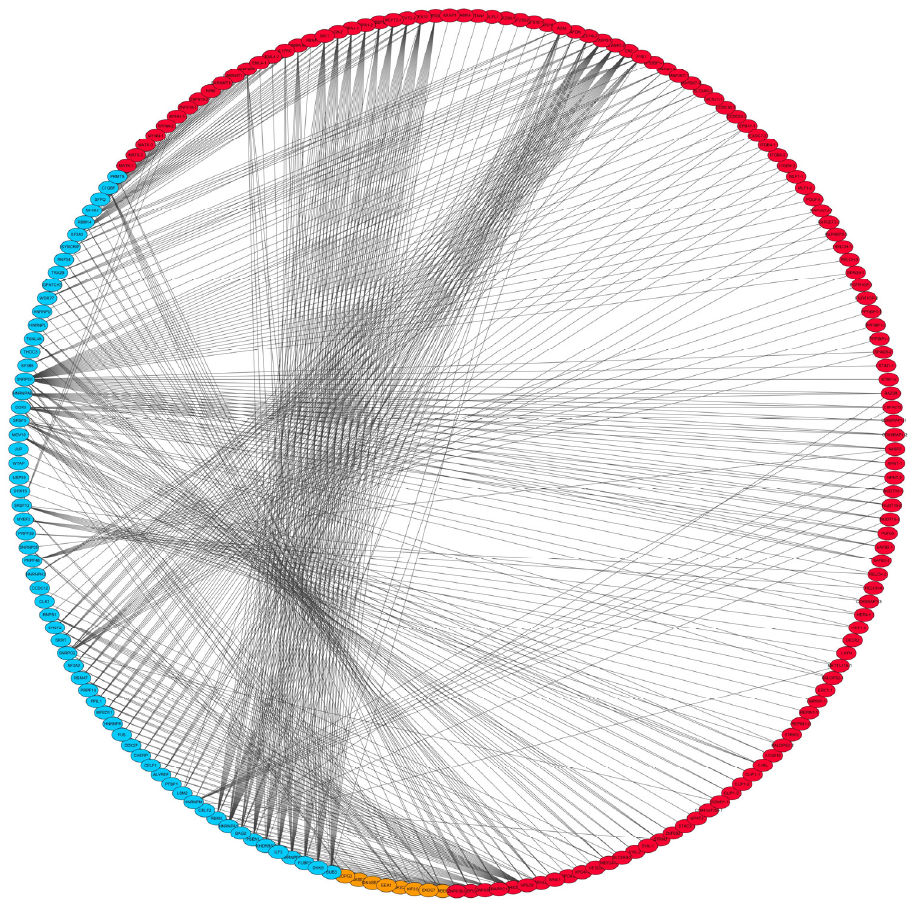
Figure 3. SF − AS interaction network. Gene marked in red or orange means the one with screened DAS event and the suffix such as “ − 1” or “ − 2” means each AS event in this gene. Gene marked in blue means the SF. In addition, orange represents the gene enriched for immune system related pathways.